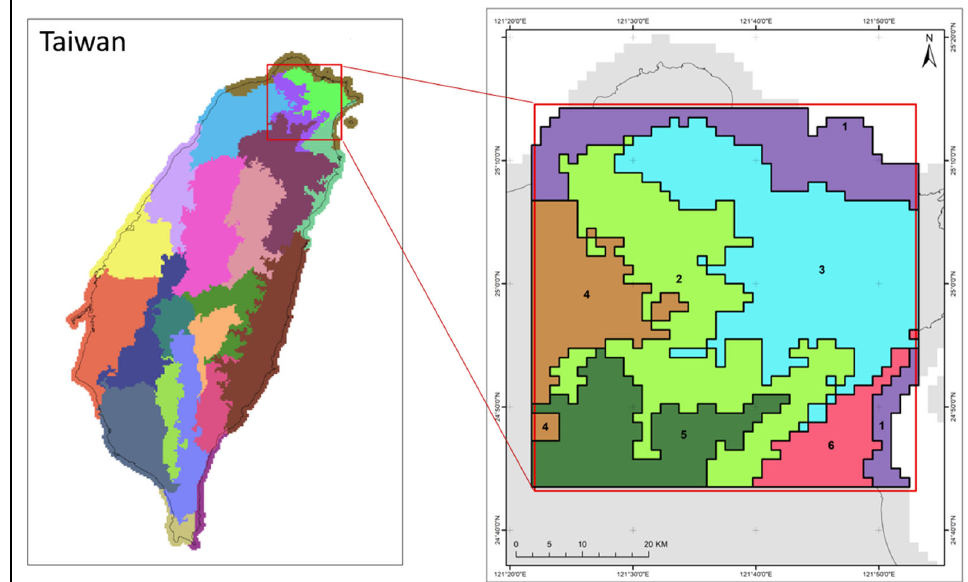
Figure 13. Region of Interest in Northern part of Taiwan used for spatial investigation.